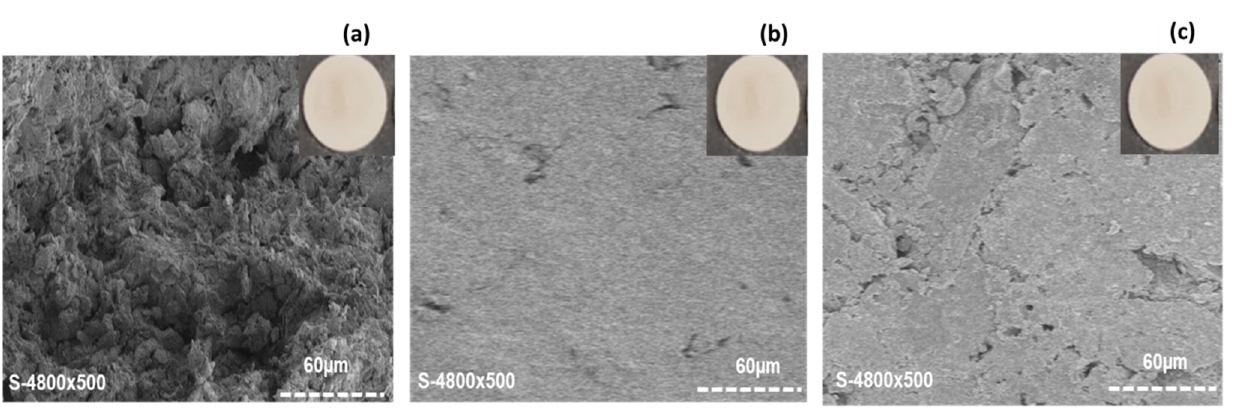
Figure 2. SEM pictures of the bio-based membranes S1 ( a ), S2 ( b ) and S3 ( c ). Pictures of membranes are also given at the top corners.